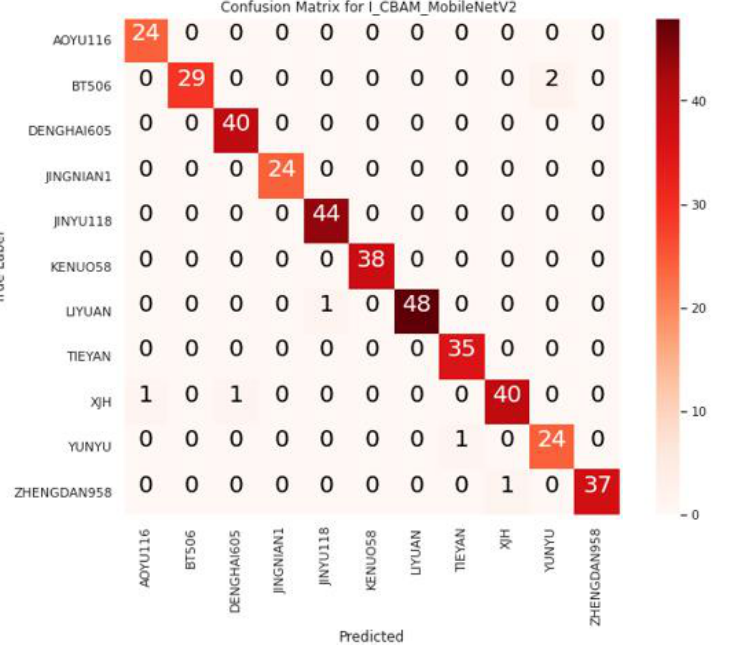
Table 4. I_CBAM_MobileNetV2 quantitative evaluation results.